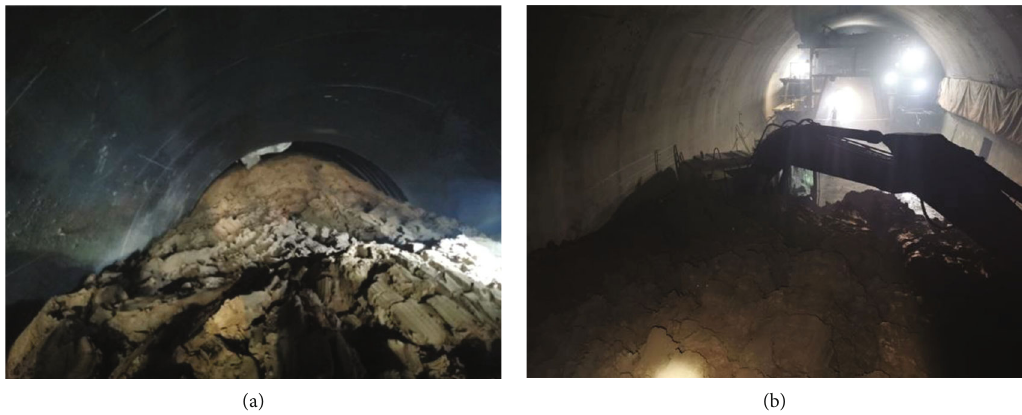
Figure 4: Accident scene: (a) collapse and mud bursting in tunnel; (b) excavator fl ushed away by inrush mud.